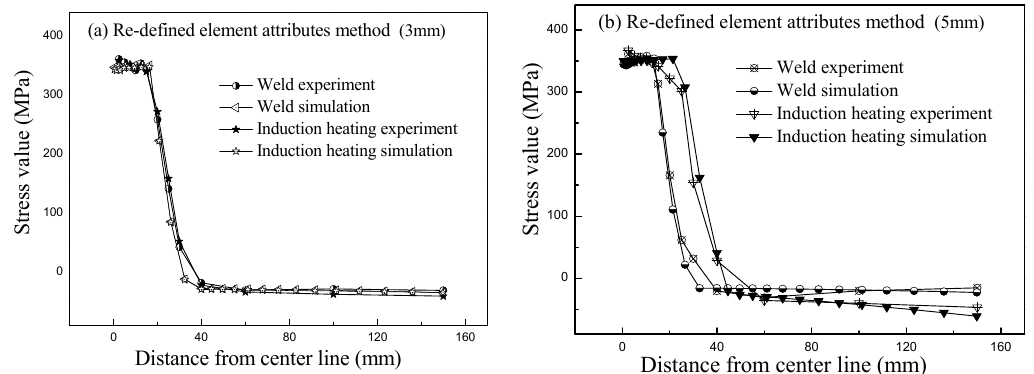
Figure 17. Comparison of longitudinal residual stress between re-defined element attributes method